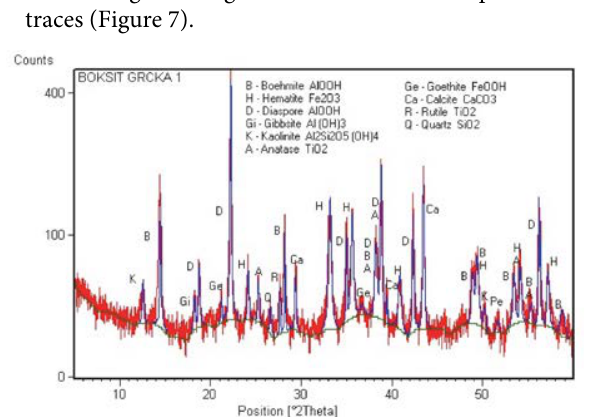
Another equation for calculating the percentage (mass %) of titanium dioxide in annealed bauxite was also derived based on the calibration curve obtained for the beads resulting from the process of pressing, Eq. (2):